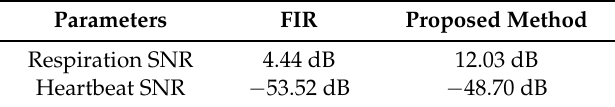
Table 2. SNR of respiration and heartbeat signal using FIR filter and the proposed method.